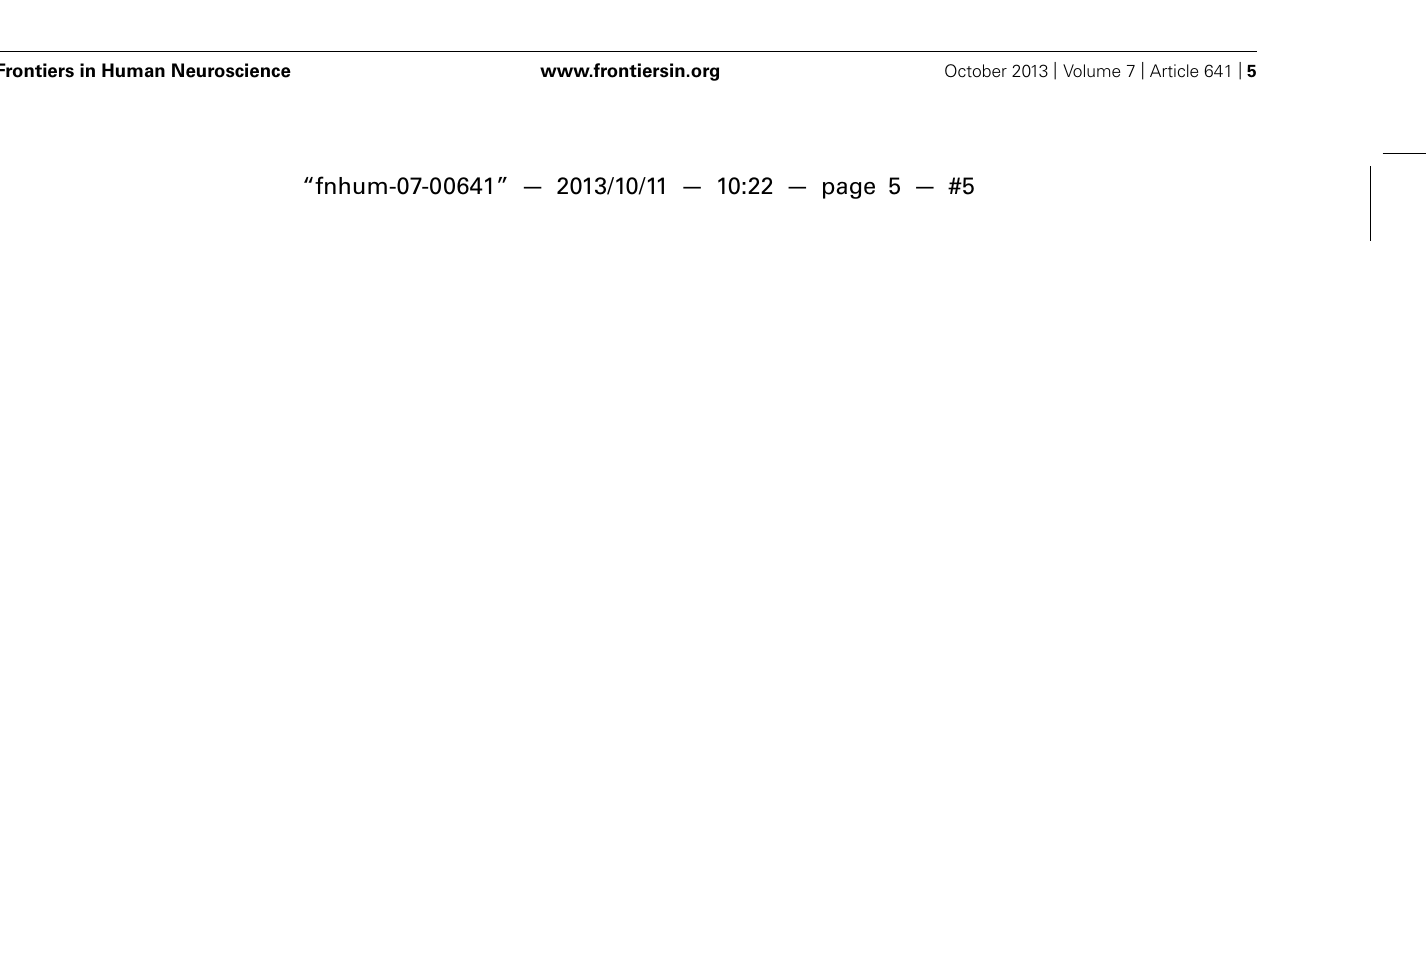
a maximum over centro-parietal electrode sites [main effect of electrode site; anteriority F (2,52) = 18,138, p < 0.001, partial η 2 = 0.411;